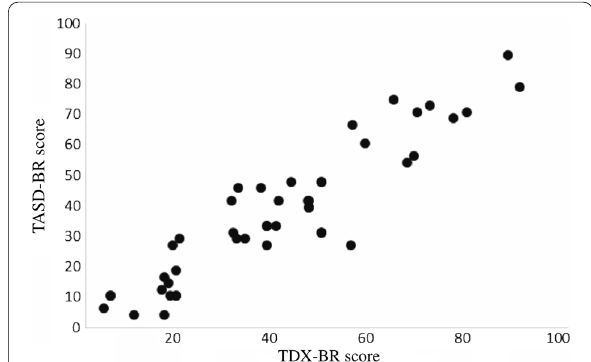
Fig. 1 Correlation between the patients’ scores on the TDX-BR and TASD-BR questionnaires